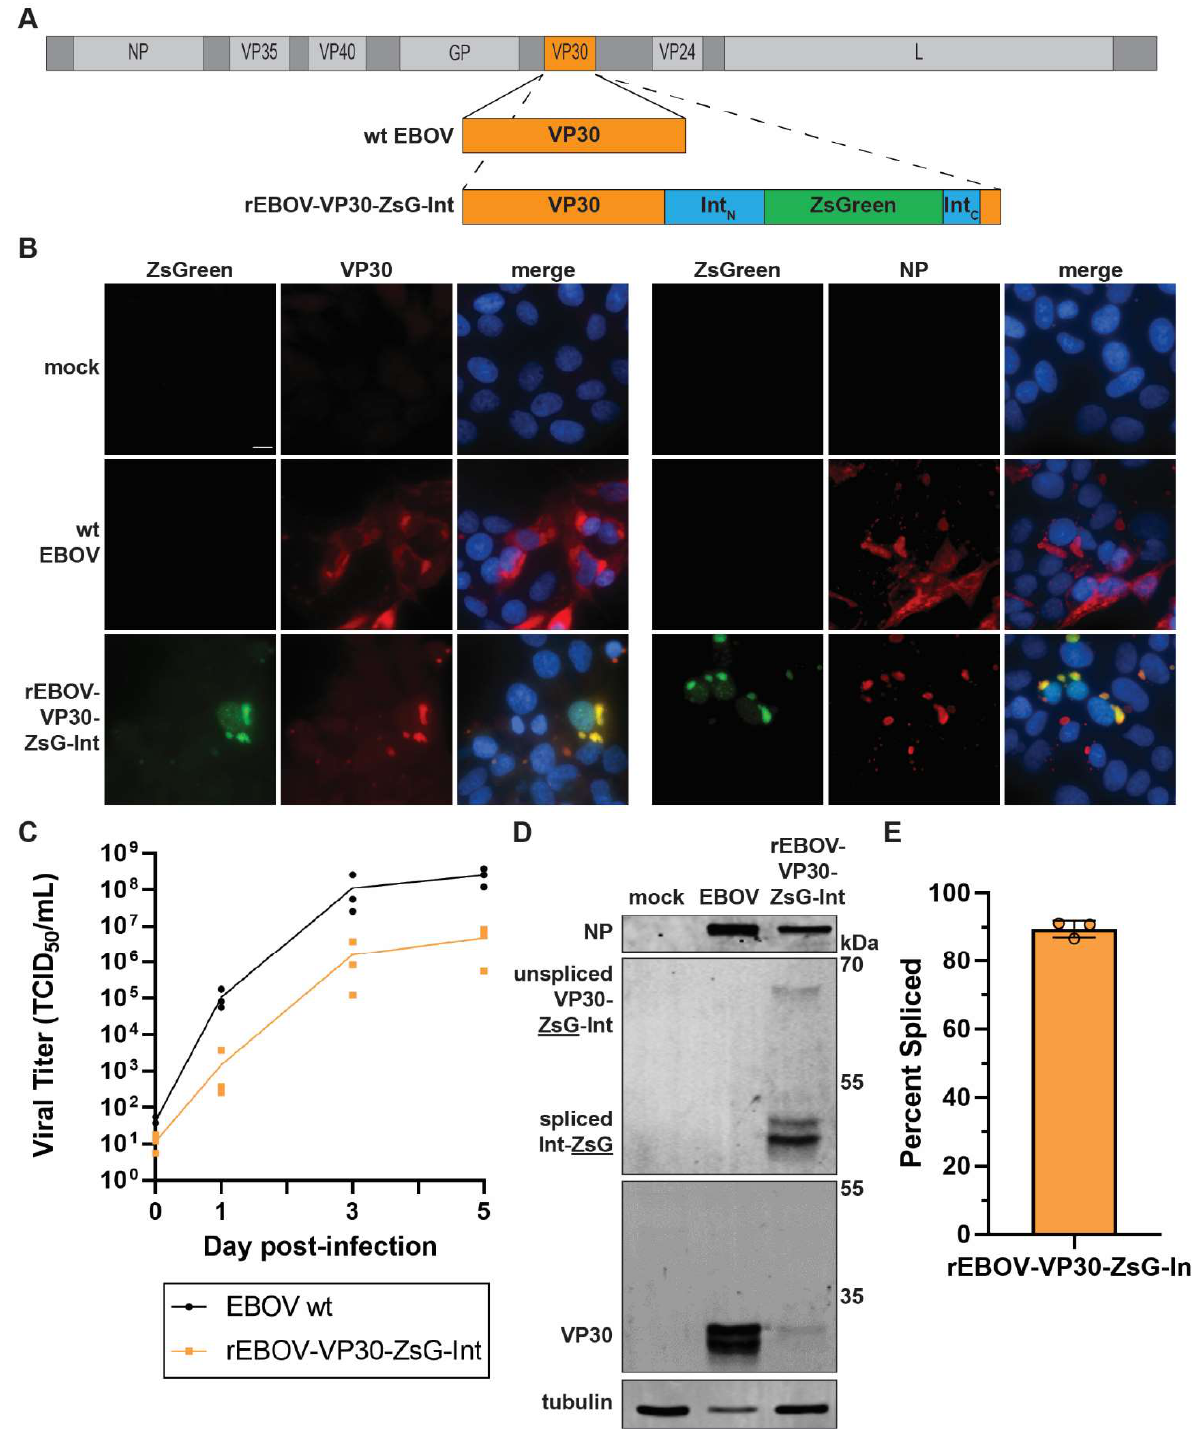
Figure 4. Rescue of recombinant EBOV containing VP30-ZsG-Int. ( A ) Diagram of wt EBOV genome versus rEBOV-VP30-ZsG-Int. Diagram is to scale. VP30 ORF in orange, other ORFs in light gray, intein N terminus (Int-N) and C terminus (Int-C) in blue, ZsGreen in green, non-coding regions in dark gray. ( B ) Fluorescence microscopy of Huh7 cells infected with wt EBOV or rEBOV-VP30-ZsG-Int at a multiplicity of infection (MOI) of 3. Cells were fixed at 1 day post-infection (dpi) and stained for EBOV VP30 or NP as indicated. Scale bar = 10 μm. Images were taken with 100× objective. ( C ) Growth curve comparing wt EBOV and rEBOV-VP30-ZsG-Int. Vero E6 cells were infected at an